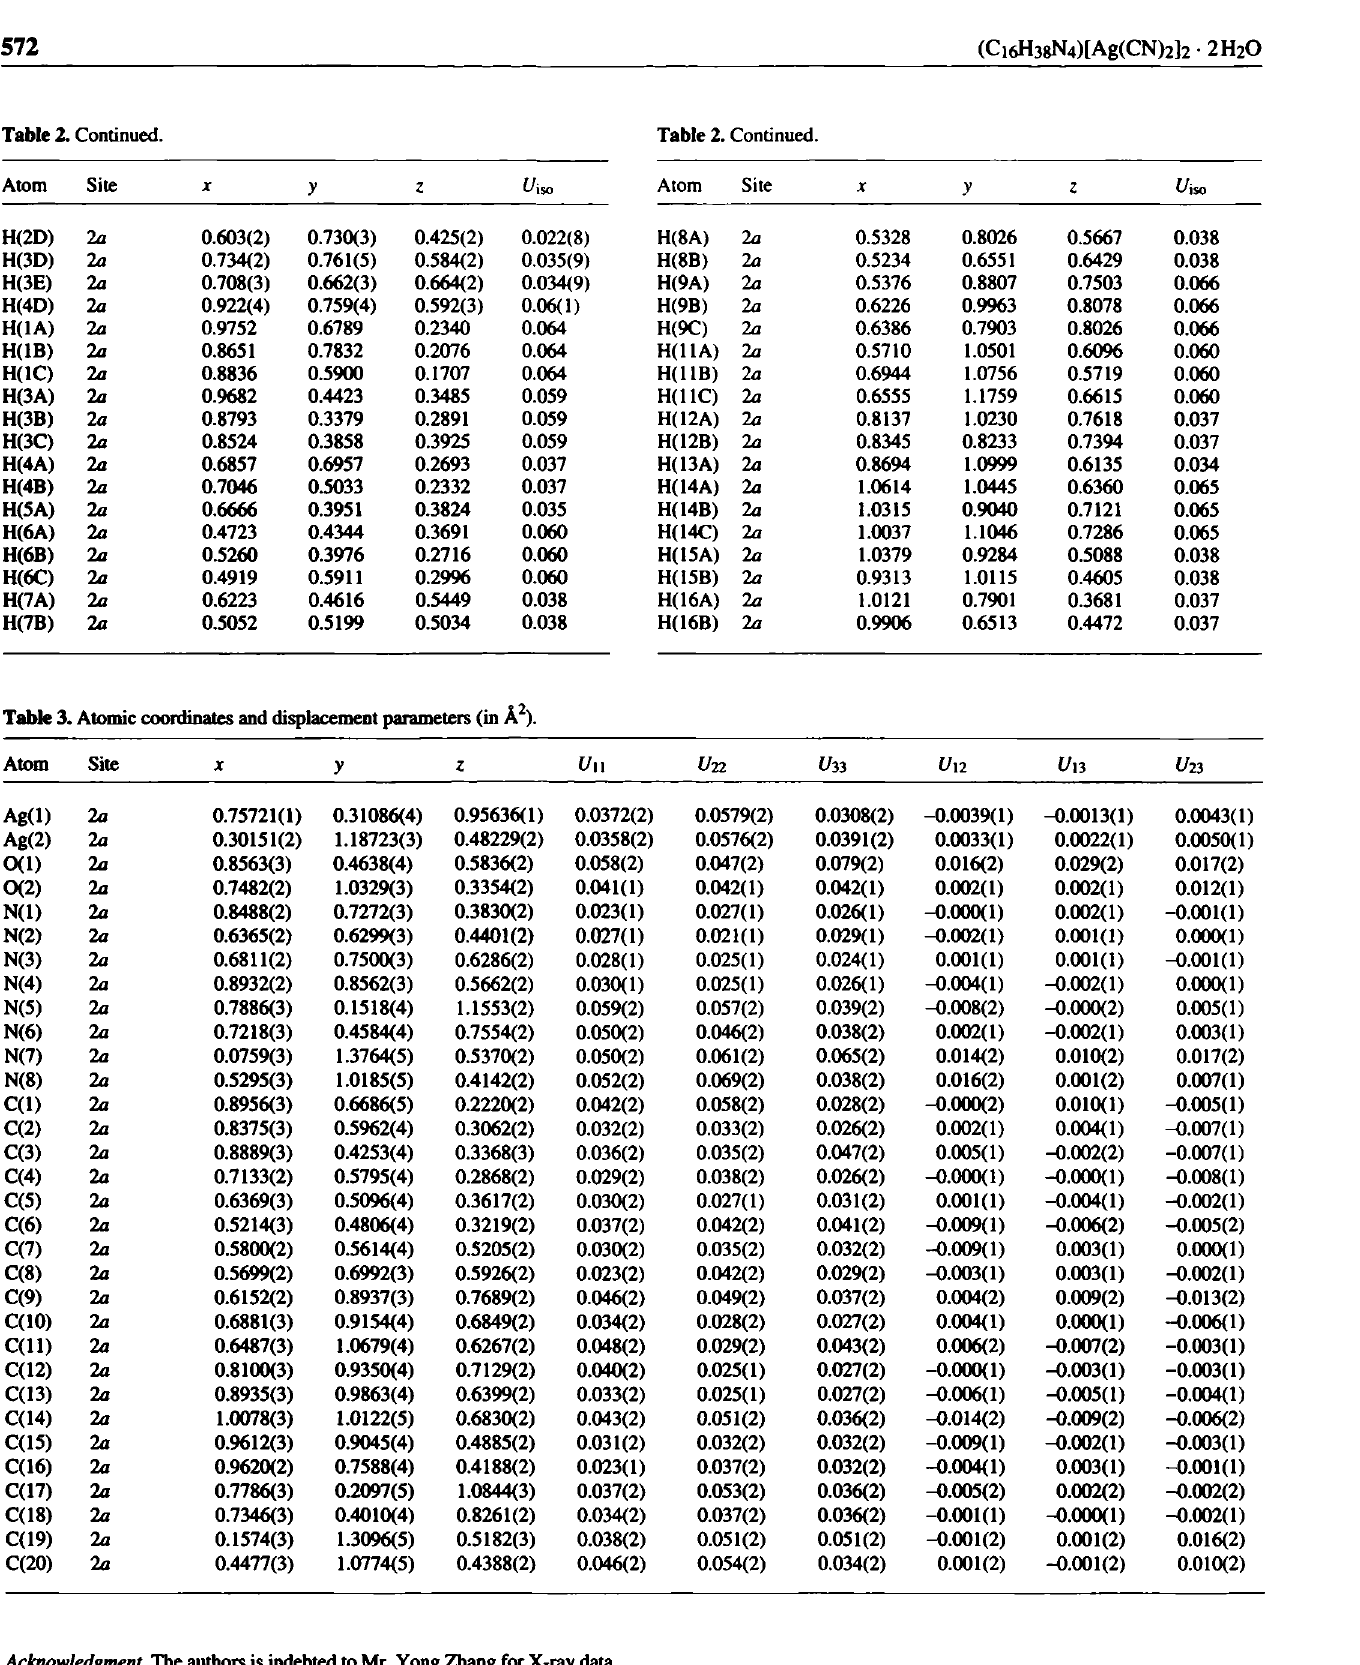
Table 3. Atomic coordinates and displacement parameters (in A 2